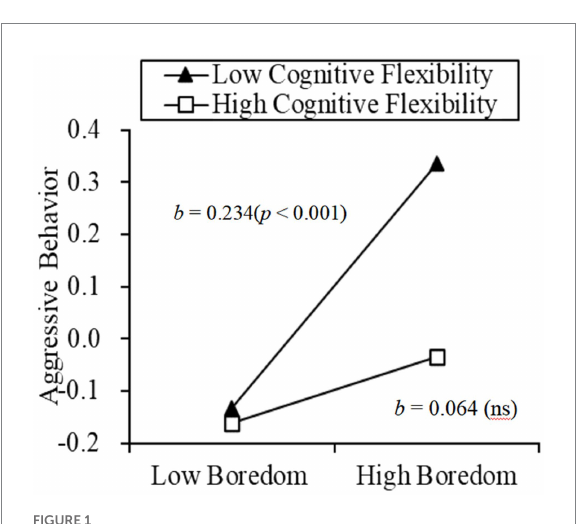
FIGURE 1 Moderation effect of cognitive flexibility on the relationship between boredom and aggressive behavior.